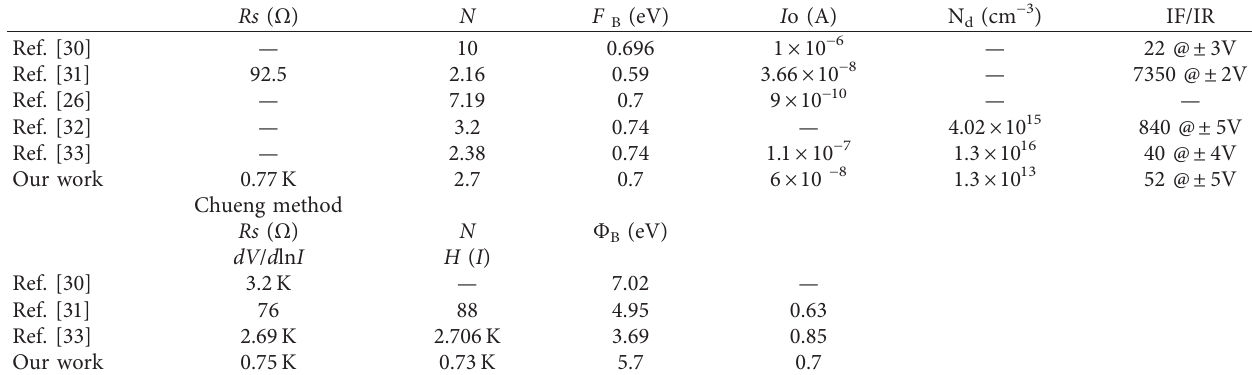
Figure 7: H ( I ) vs. forward current. Table 1: Extracted parameters of Si/ZnO heterojunction and comparison with the previous